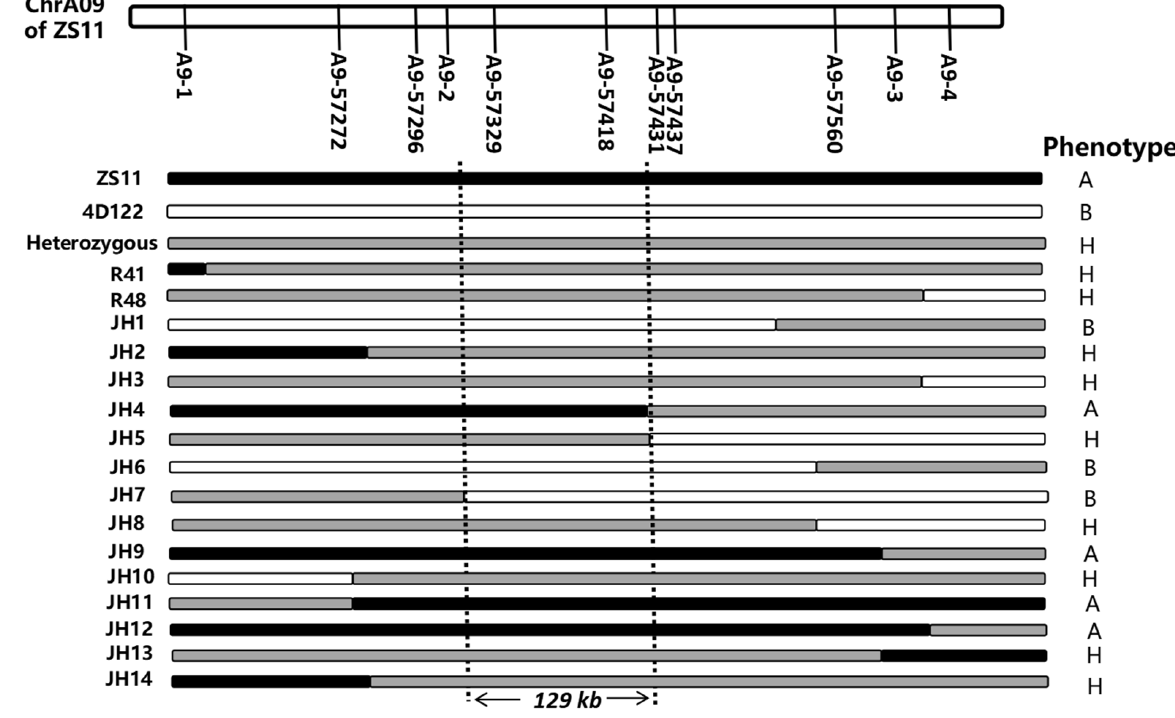
Figure 5. Fine mapping of the QTL RT.A09 . The genotype and phenotype of recombinants using 11 developed PARMS markers of RT.A09 . “A” and “B” represent that the offspring phenotypes of the recombinant line were similar to NIL-A and NIL-B, respectively, of its sister lines. “H” represents that the offspring phenotypes of the recombinant line were separated according to their genotypes.